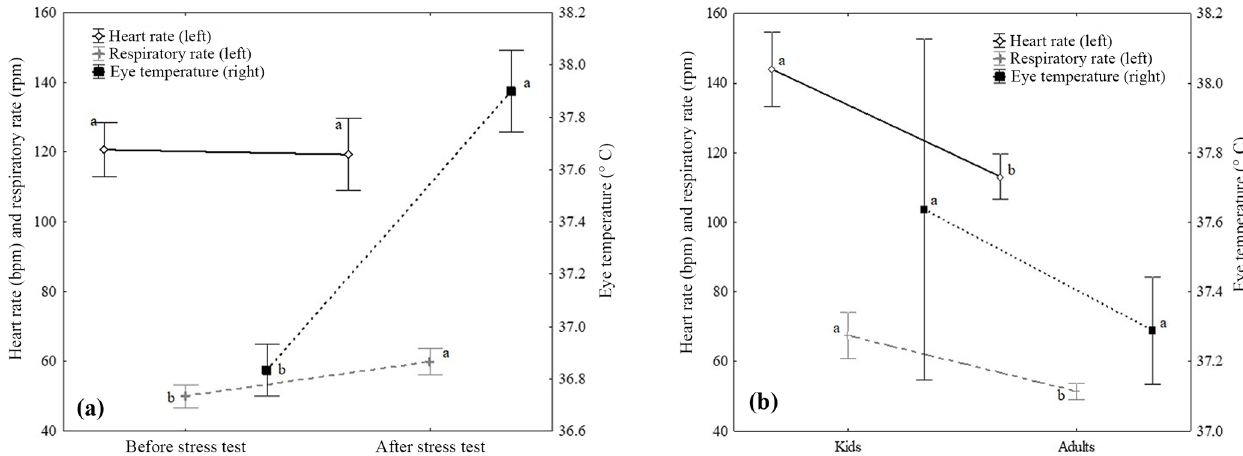
Figure 1. Least square means analysis (mean ± standard error) and Scheffé post hoc comparison test (indicated with letters) for the stress variables with statistically significant results in the ANOVA test due to the stress test moment (a) and the age of the animals (b) . Different letters indicate statistically significant differences ( p< 0 . 05) between means.